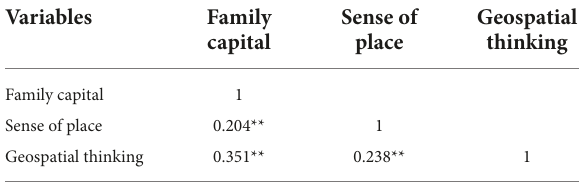
TABLE 2 Pearson’s r for the three